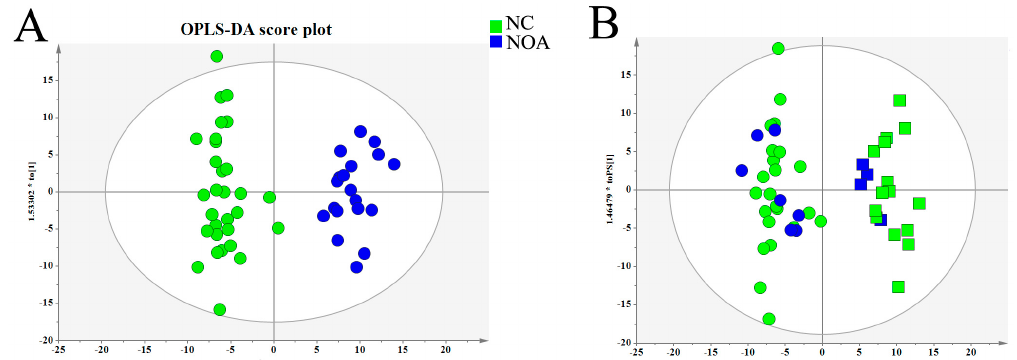
Figure 3. Orthogonal partial least squares-discriminant analysis (OPLS-DA) of serum metabolites in NOA and NC. ( A ) OPLS-DA score plot; ( B ) t -predicted scatter plot of the test set. Green squares: training set of azoospermia; green circles: training set of healthy control; blue squares: test set of azoospermia; blue circles: test set of healthy control.